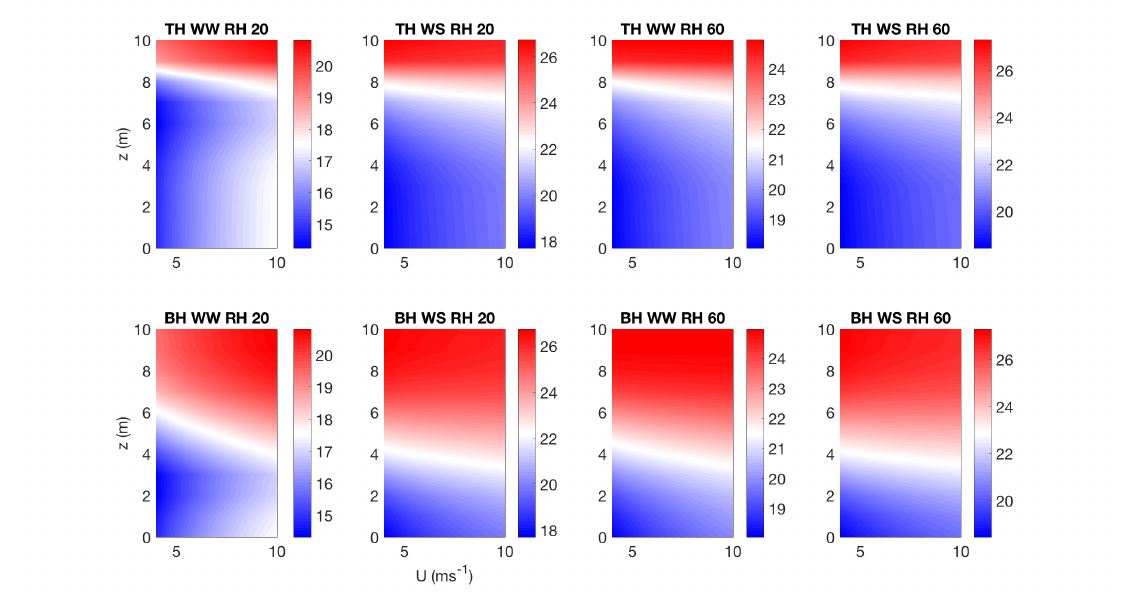
Figure 11. Similar to Figure 10 but for the higher light condition. The color bars indicate leaf level canopy temperature in ◦